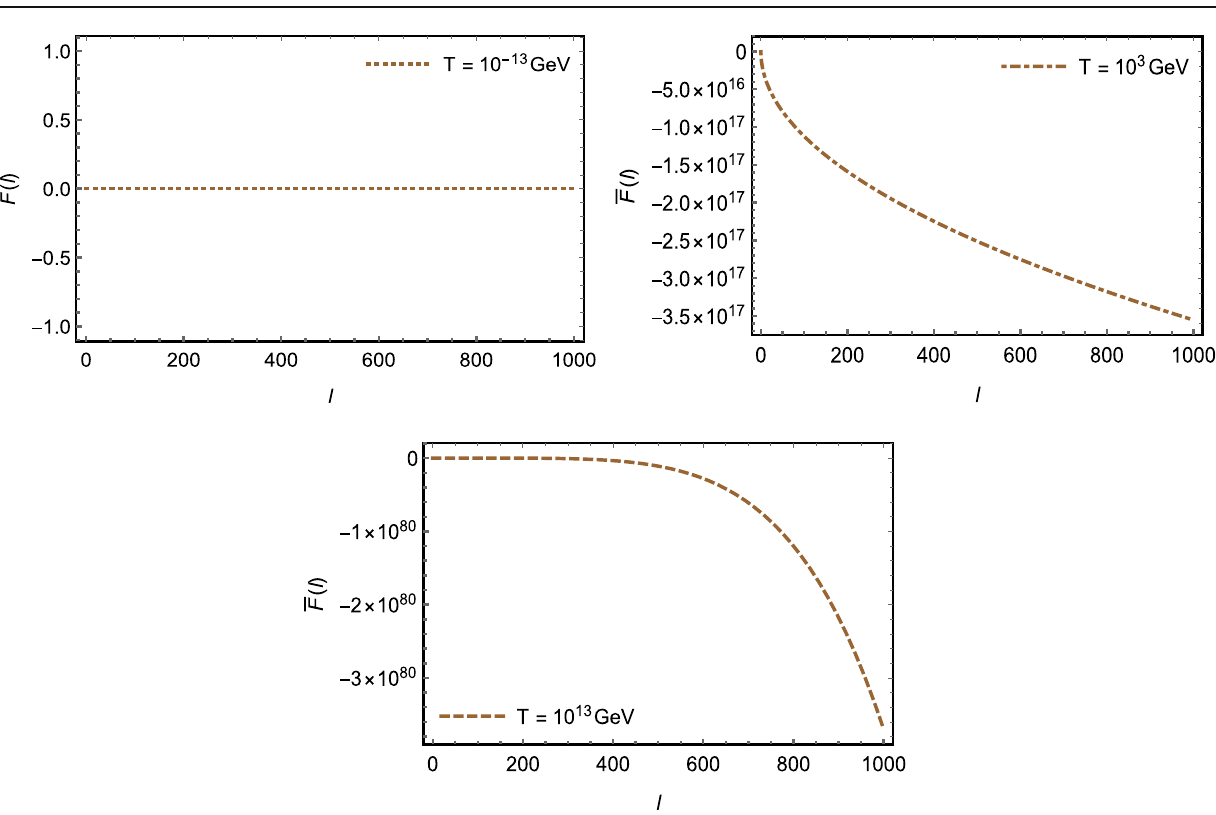
Fig. 10 The figure shows the modification of the Helmholtz free energy ¯ F as a function of l ( whose dimension is m · kg − 1 / 2 · s − 1 ) considering the temperatures of cosmic microwave background (top left), electroweak scenario (top right), and the early inflationary universe (bottom)